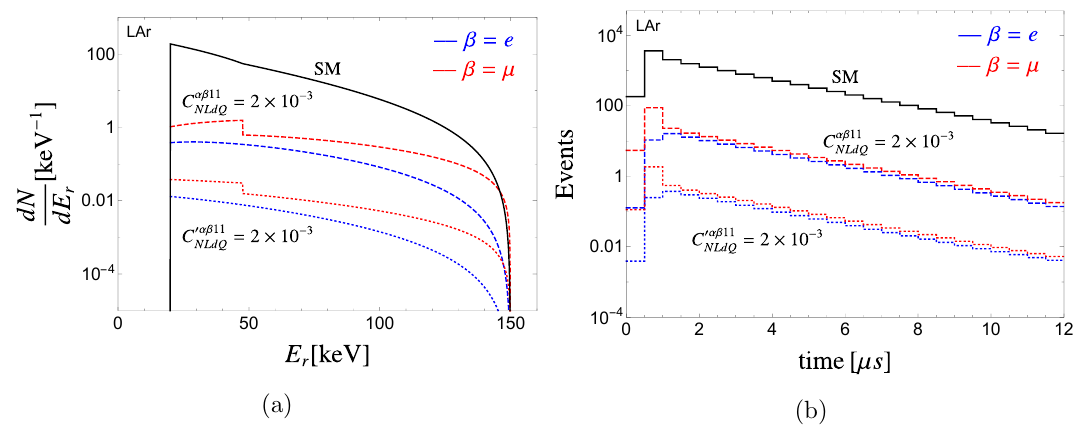
Figure 3. The recoil energy (left) and temporal (right) distributions in a future COHERENT LAr detector. Threshold e(cid:11)ects are included. The black solid lines are the SM case including all (cid:13)avors. The blue (red) curves correspond to the electron (muon+antimuon) (cid:13)avor contributions. The dashed (dotted) curves correspond to the contributions from the scalar (tensor) interactions with C NLdQ ( C 0 ) = 2 (cid:2) 10 (cid:0) 3 . NLdQ